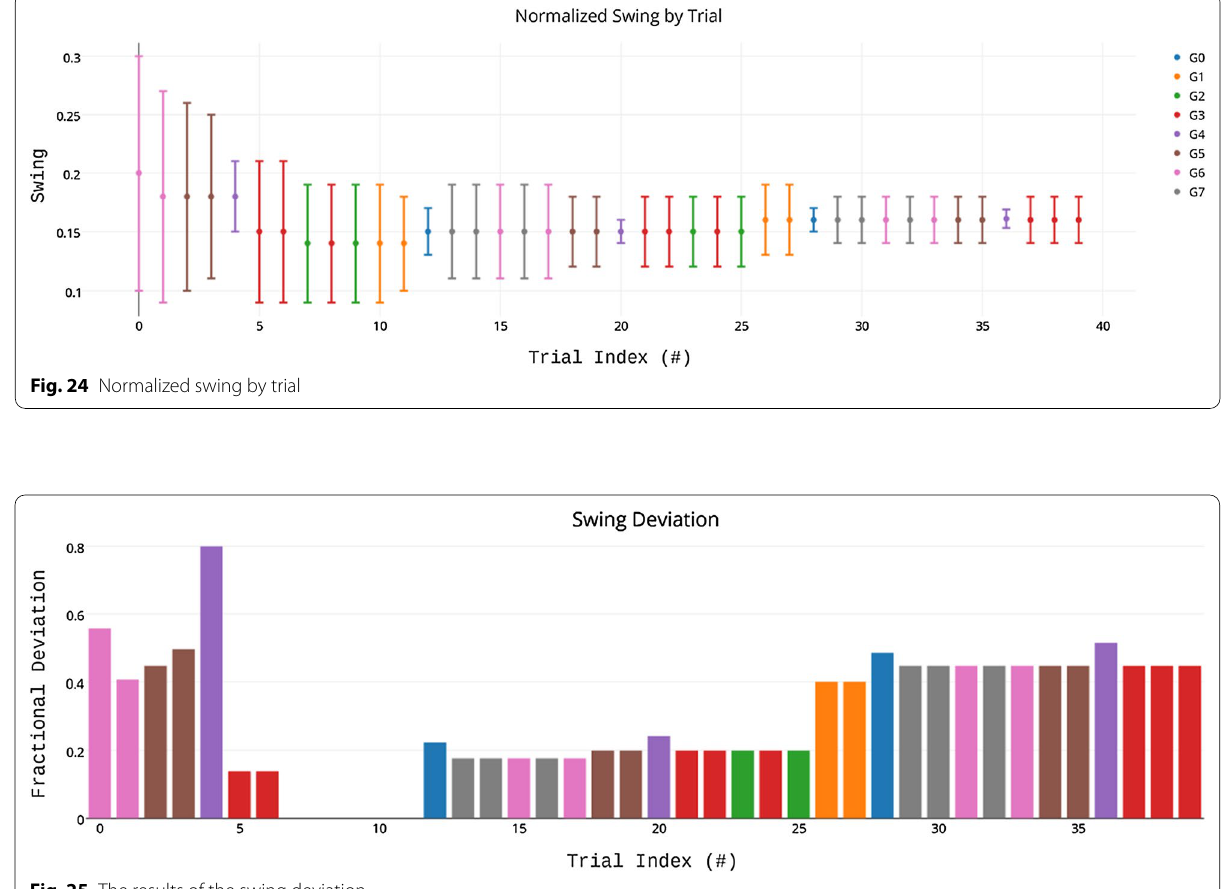
Fig. 25 The results of the swing deviation